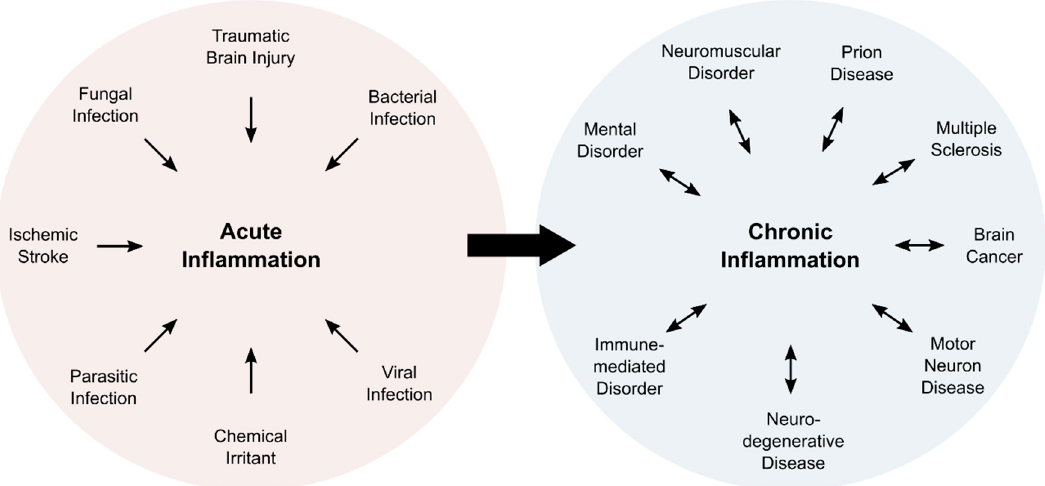
Figure 1. Overview of cause and consequence of acute and chronic inflammation. Acute inflammation is induced in response to external factors. Persisting inflammatory responses become chronic events that are associated with numerous pathologies.